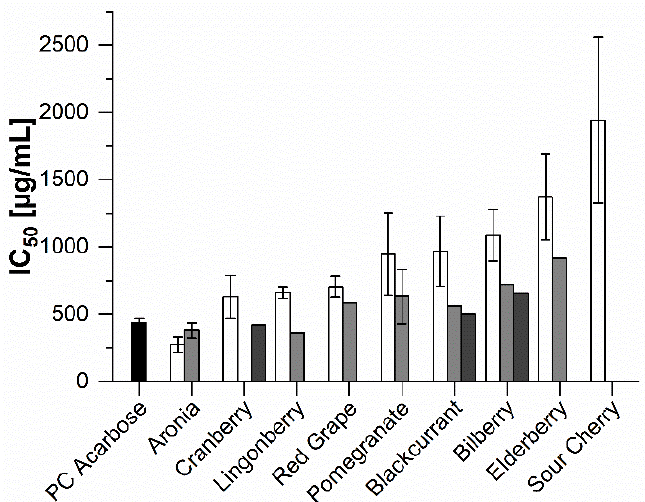
Figure 2. Inhibitory activities (IC 50 ) of the red fruit product extracts against α -amylase. Results are shown for extracts of direct juice (white), juice concentrate (light grey), purees (dark grey), and the positive control (PC) acarbose. Bars represent means ± SD ( n = 3).